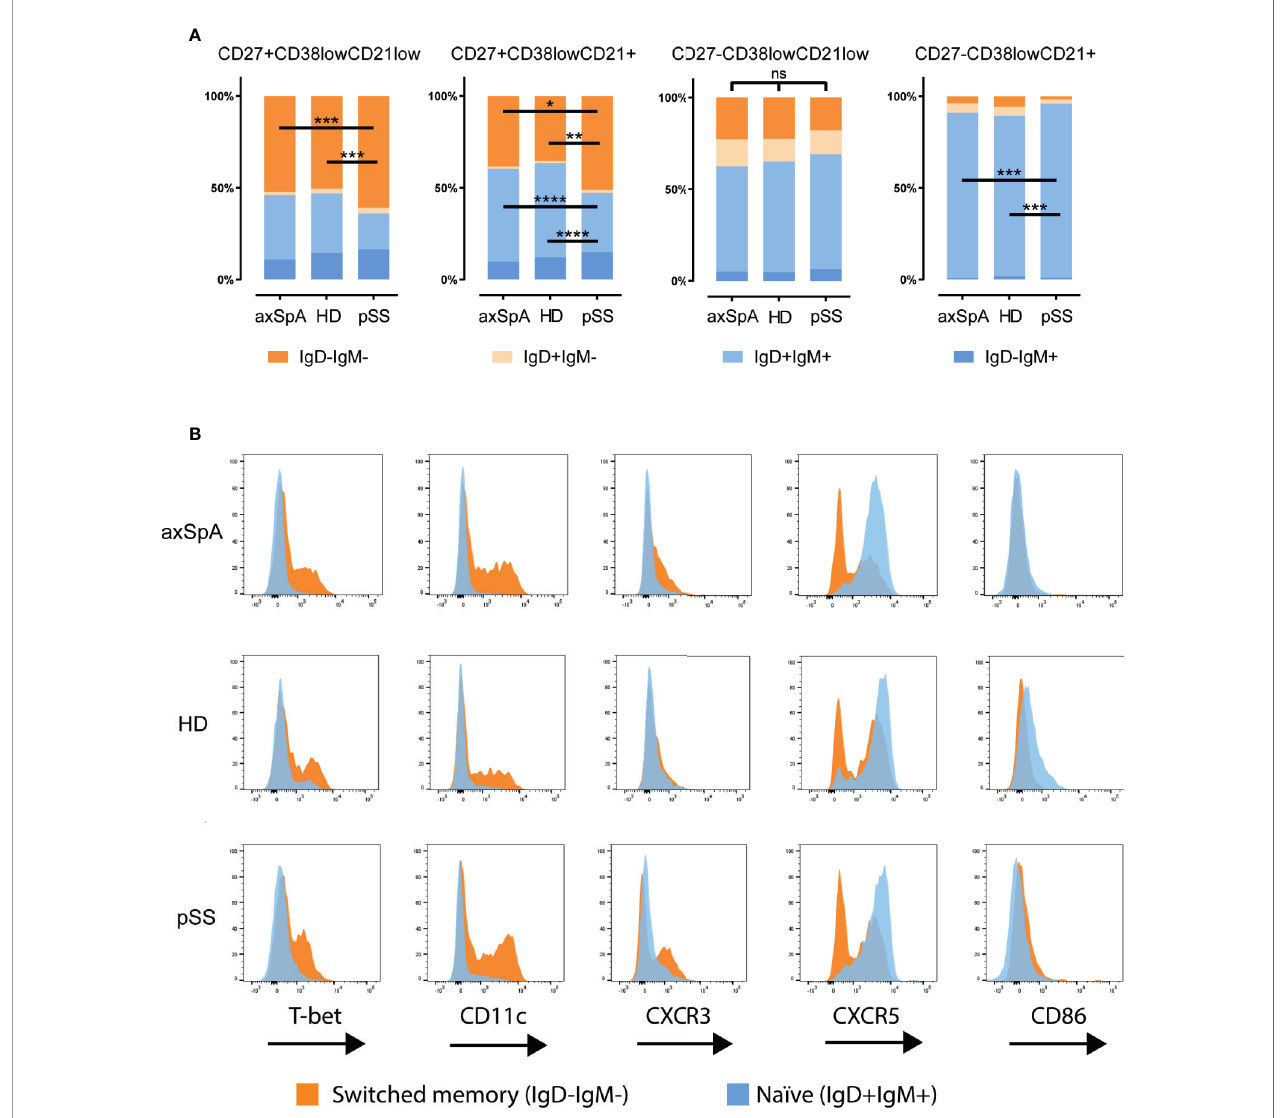
FIGURE 3 | Distribution of immunoglobulins IgD and IgM by CD27CD38 low CD21 B-cell compartment in patients with axSpA, pSS and HDs. Analysis of the distribution of immunoglobulins IgD and IgM (A) is shown for CD27 + CD38 low CD21 low , CD27 + CD38 low CD21 + , CD27 - CD38 low CD21 low , CD27 - CD38 low CD21 + B-cells respectively. A more detailed analysis of the immune marker expression (B) by the naïve (IgD + IgM + ) in orange and switched (IgD - IgM - ) B-cell populations in blue shown as histogram plots comparing CD27 - CD38 low CD21 low B-cell populations of one axial spondyloarthritis patient, one primary Sjögren ’ s syndrome patient and a healthy donor. *P < 0.05, **P < 0.01, ***P < 0.001, ****P < 0.0001, ns, not signi fi cant and horizontal lines indicate the